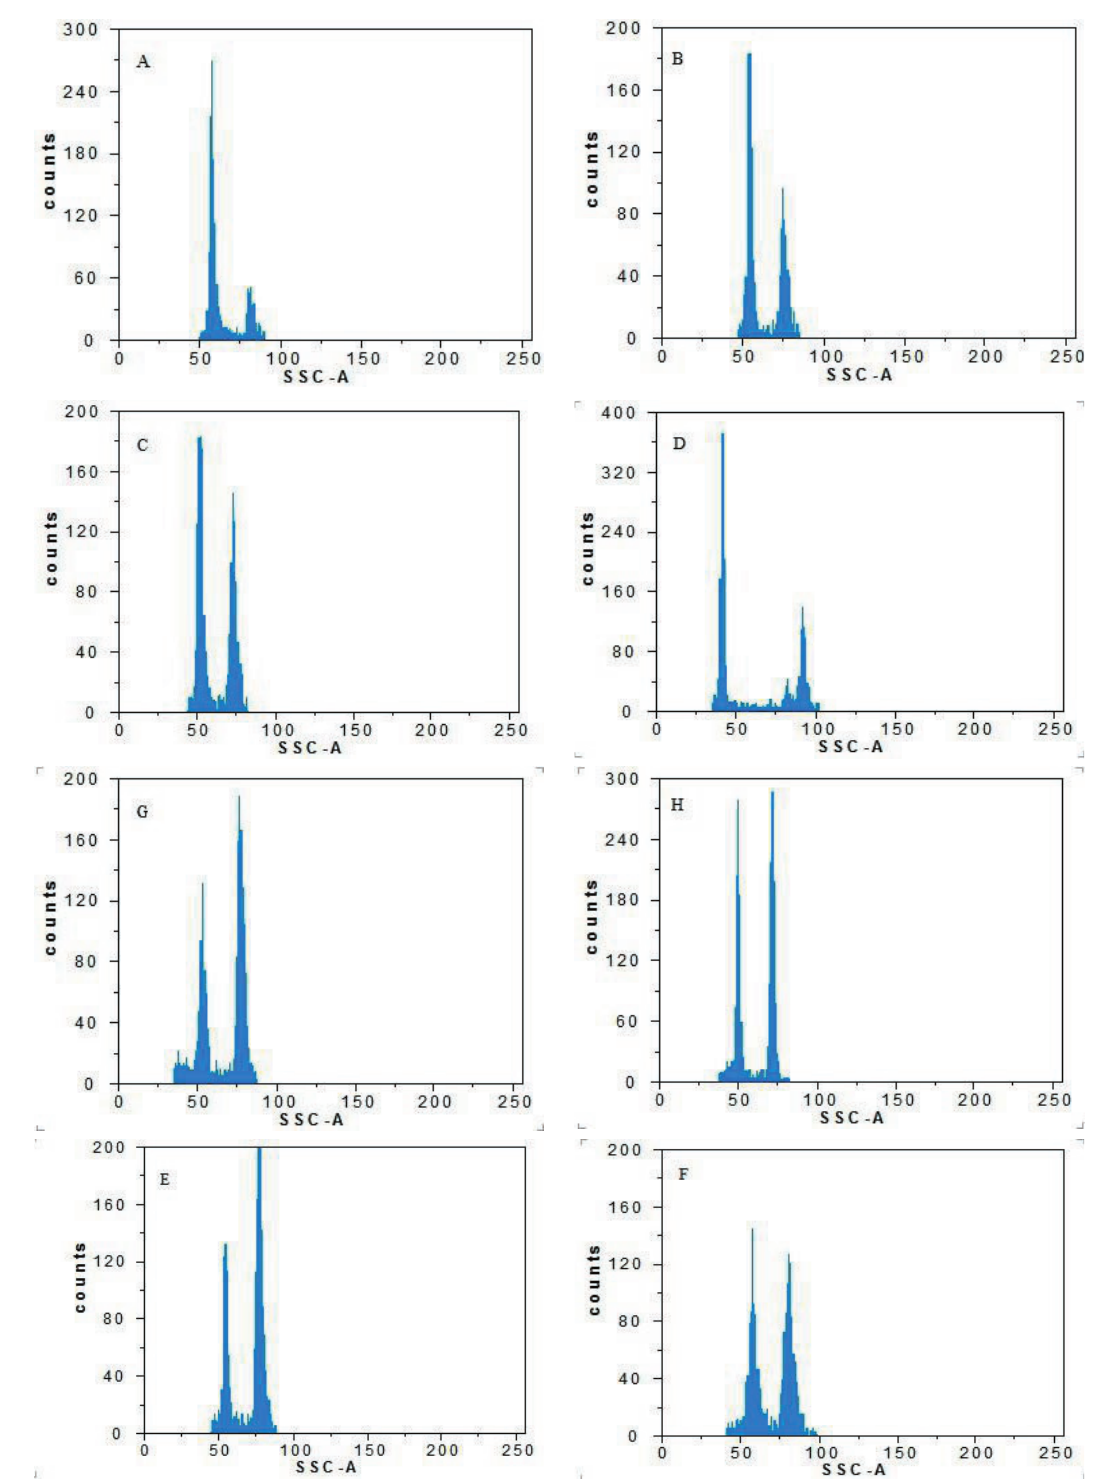
Figure 3. The histogram for analysis of the amount of nuclear DNA in leaves: The left peaks refer to the unknown Hedra samples and the right peaks to the known parsley (P. crispum) reference standard (2C DNA = 4.50 pg). A: H. crebrescens (V) = 3.19 pg. B: H. crebrescens (JH) = 3.33 pg, C: H crebrescens (Sze) = 3.22 pg . D: H. crebrescens (So) = 3.09 pg. E: H. crebrescens (GH) 5 = 3.16 pg. F: H. helix= 3.16 pg . G: H. helix arborescence = 3.16 pg, H : H. hibernica arborescence = 3.17 pg, diploids